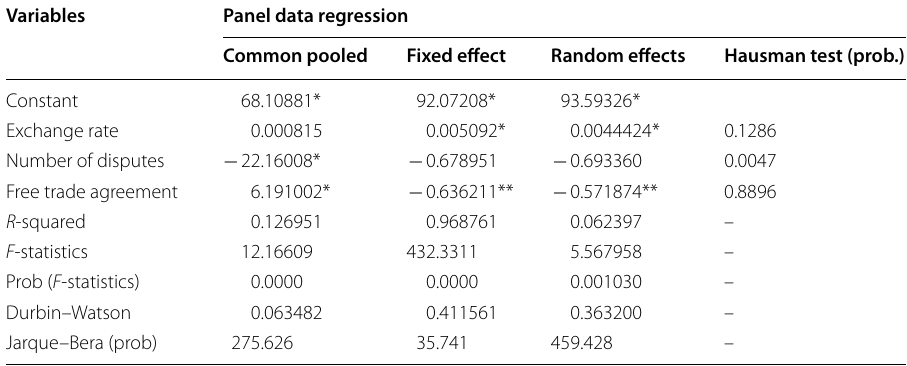
Table 2 Panel data